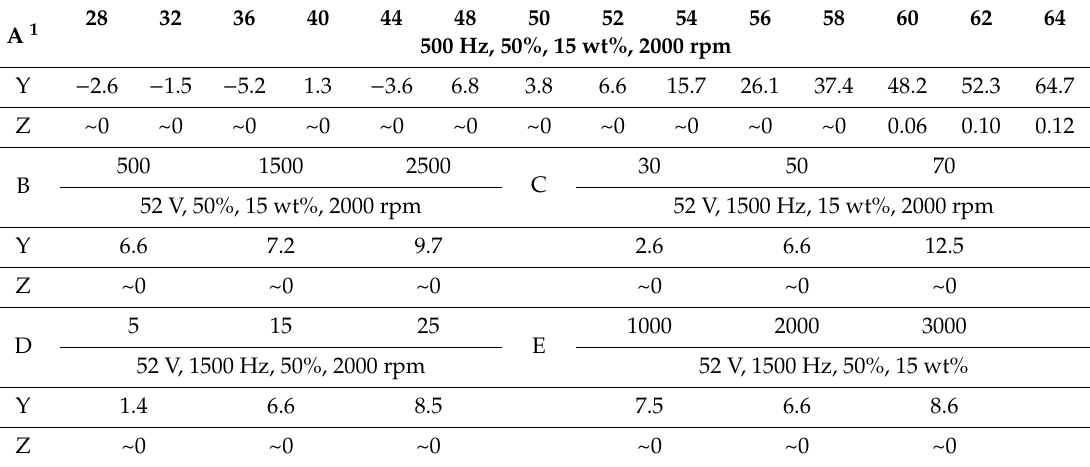
Table 3. Weight loss of cathode (Y) and the length loss of cathode (Z) in the ECDM